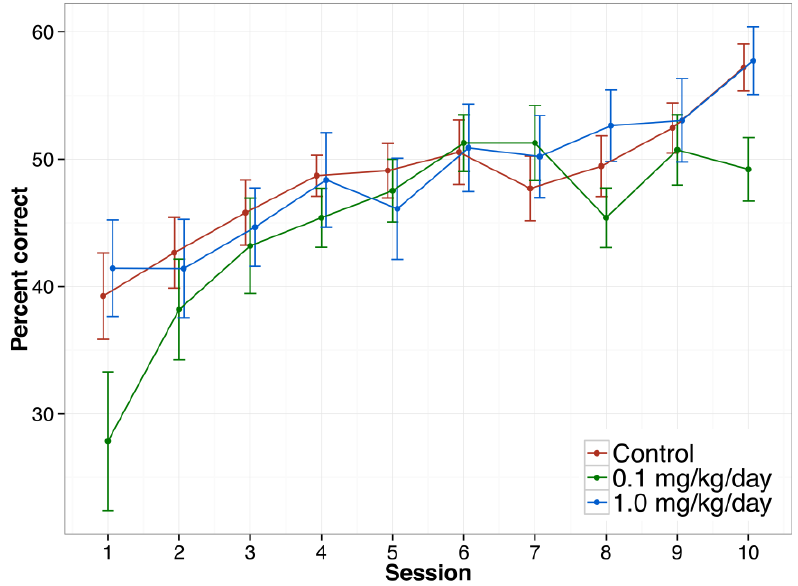
Figure 6. Delayed non-matched to sample in Phase IV over 10 days. Data represents mean ±